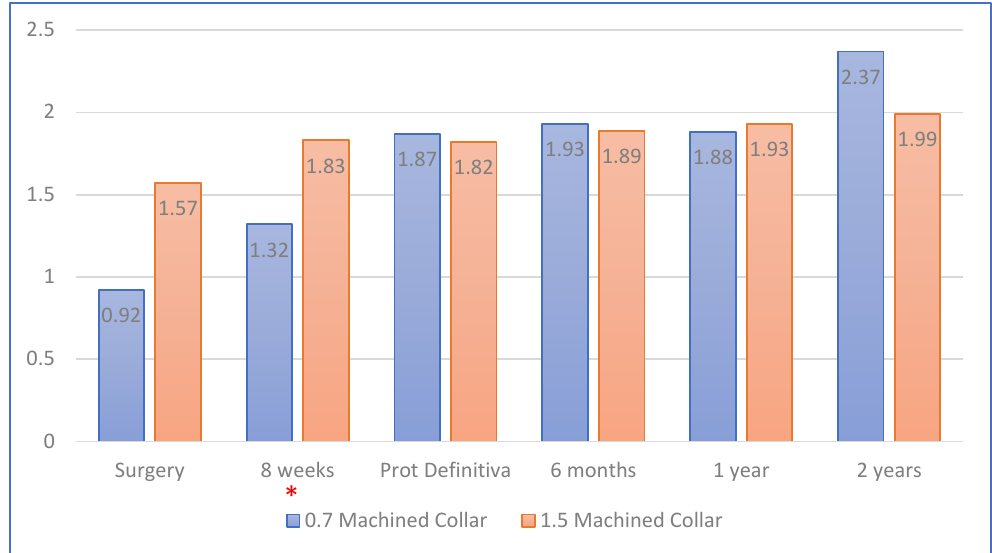
Figure 5. Shoulder–crest distance (SCD) (in mm) according to the machined collar of the implant. * Statistically significant differences ( p < 0.05).